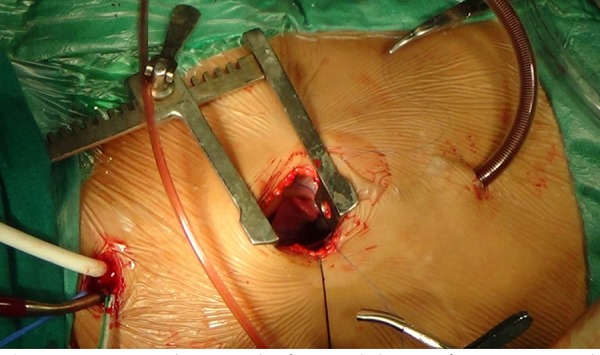
Operative photograph of surgical closure of VSD on CPB with
cervical cannulation.